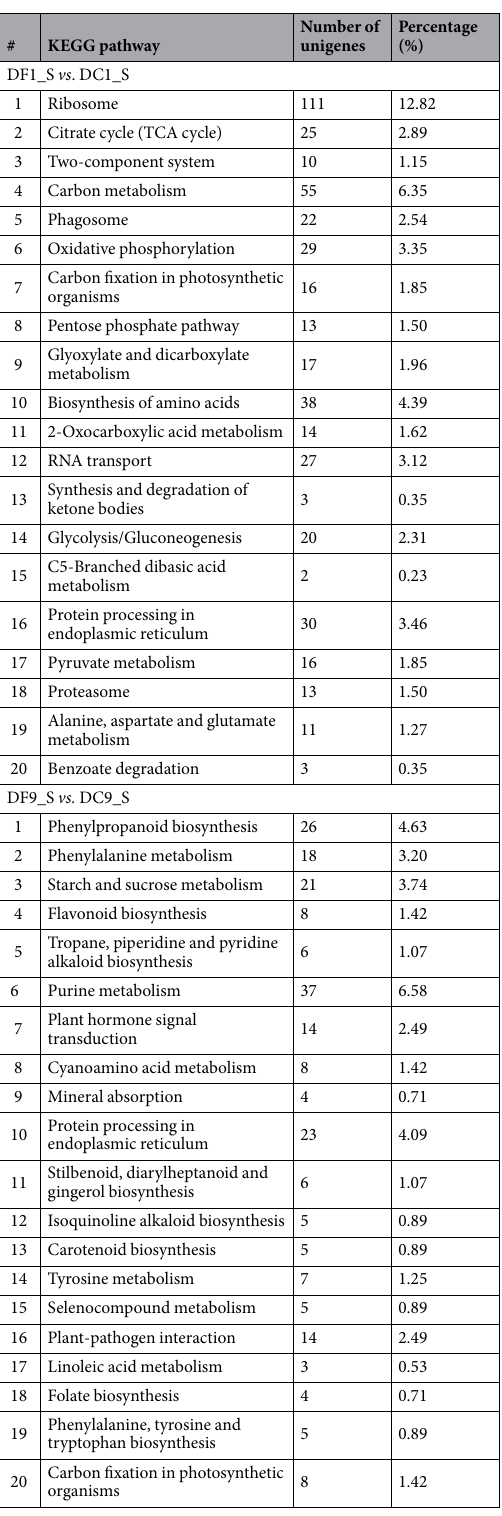
Table 1. Summary of the top 20 KEGG pathways in